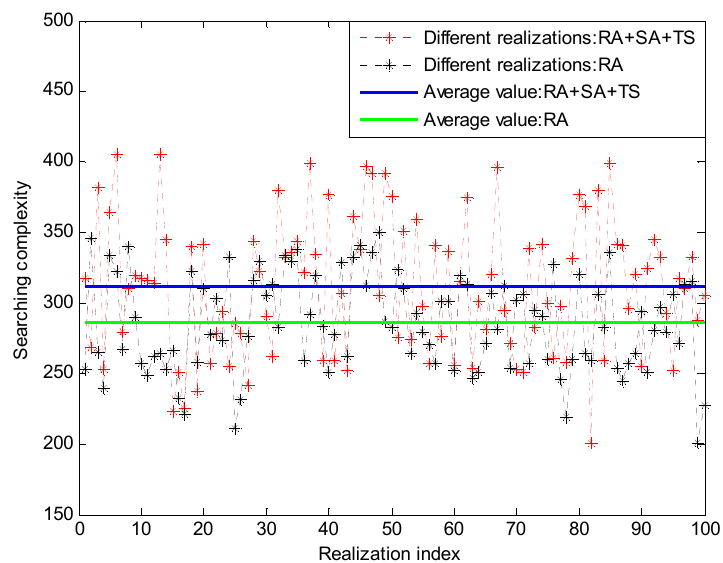
Figure 6. Search performance of the Rosenbrock algorithm (RA) and the new numerical algorithm (RA+SA+TS).